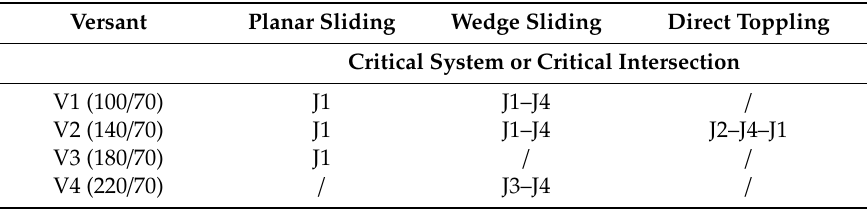
Table 3. Results of the kinematic stability analysis along four identified slopes.